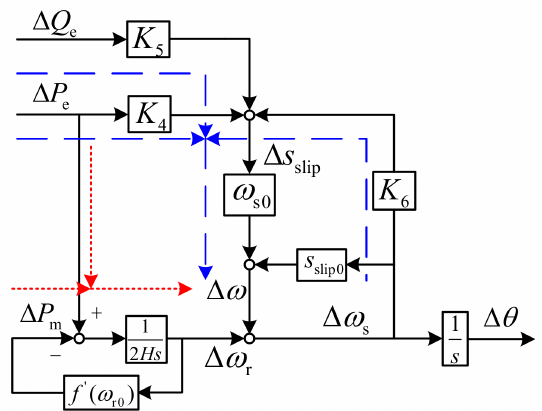
Figure 4. Small-signal block diagram of the phase motion equation of potential after transient reactance based on inertial time